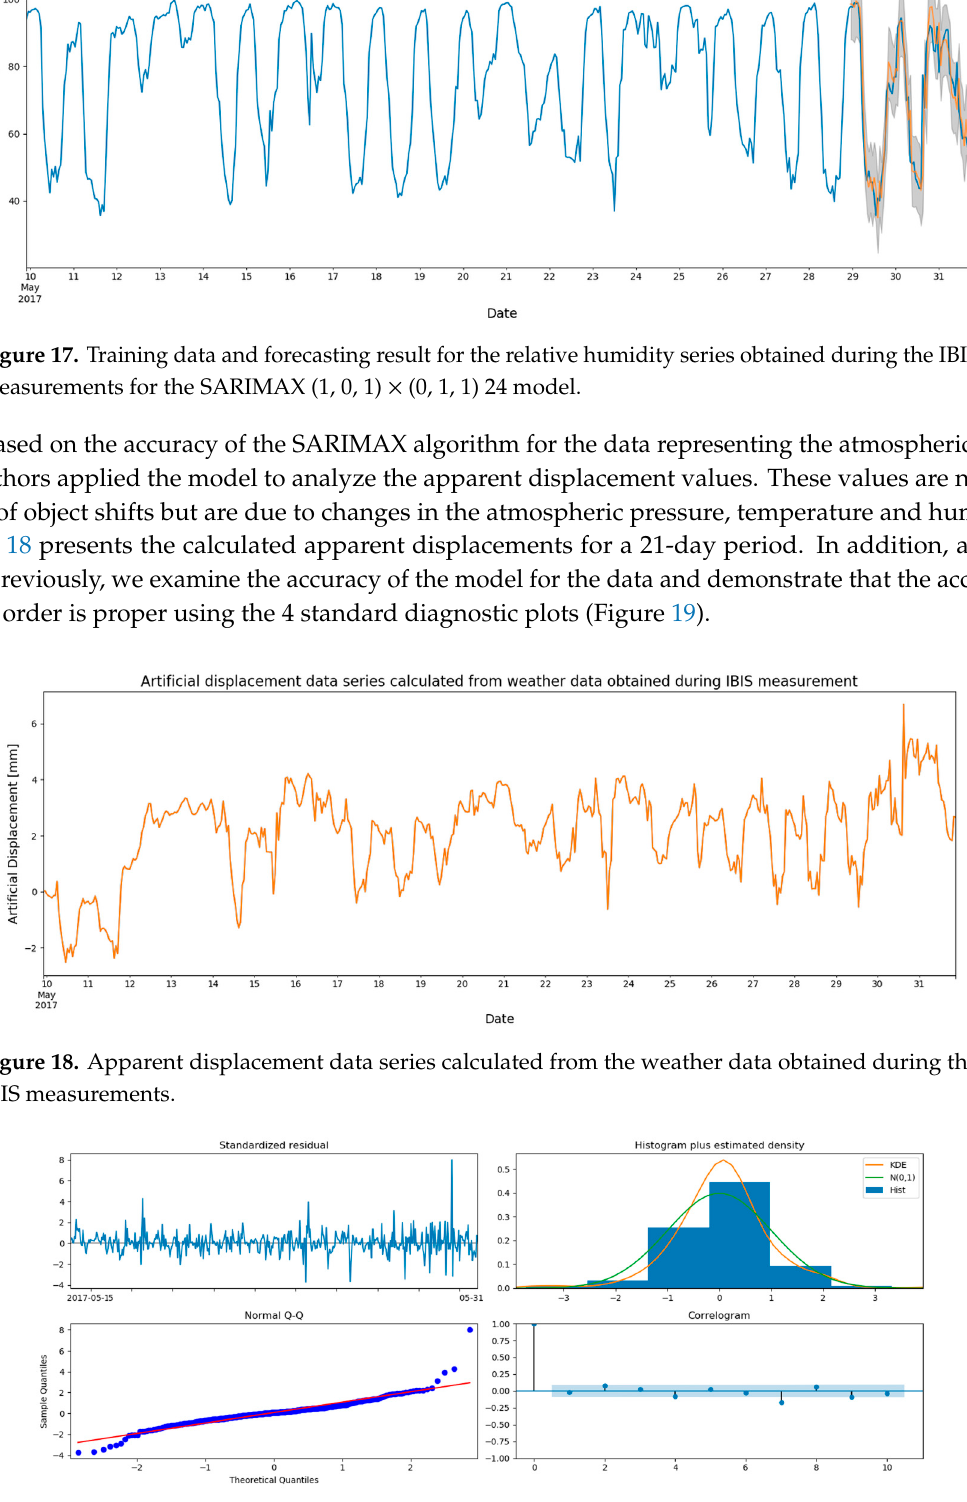
Figure 16. Diagnostic plots for the relative humidity series obtained during the IBIS measurements for the SARIMAX (1, 0, 1) × (0, 1, 1) 24 model.